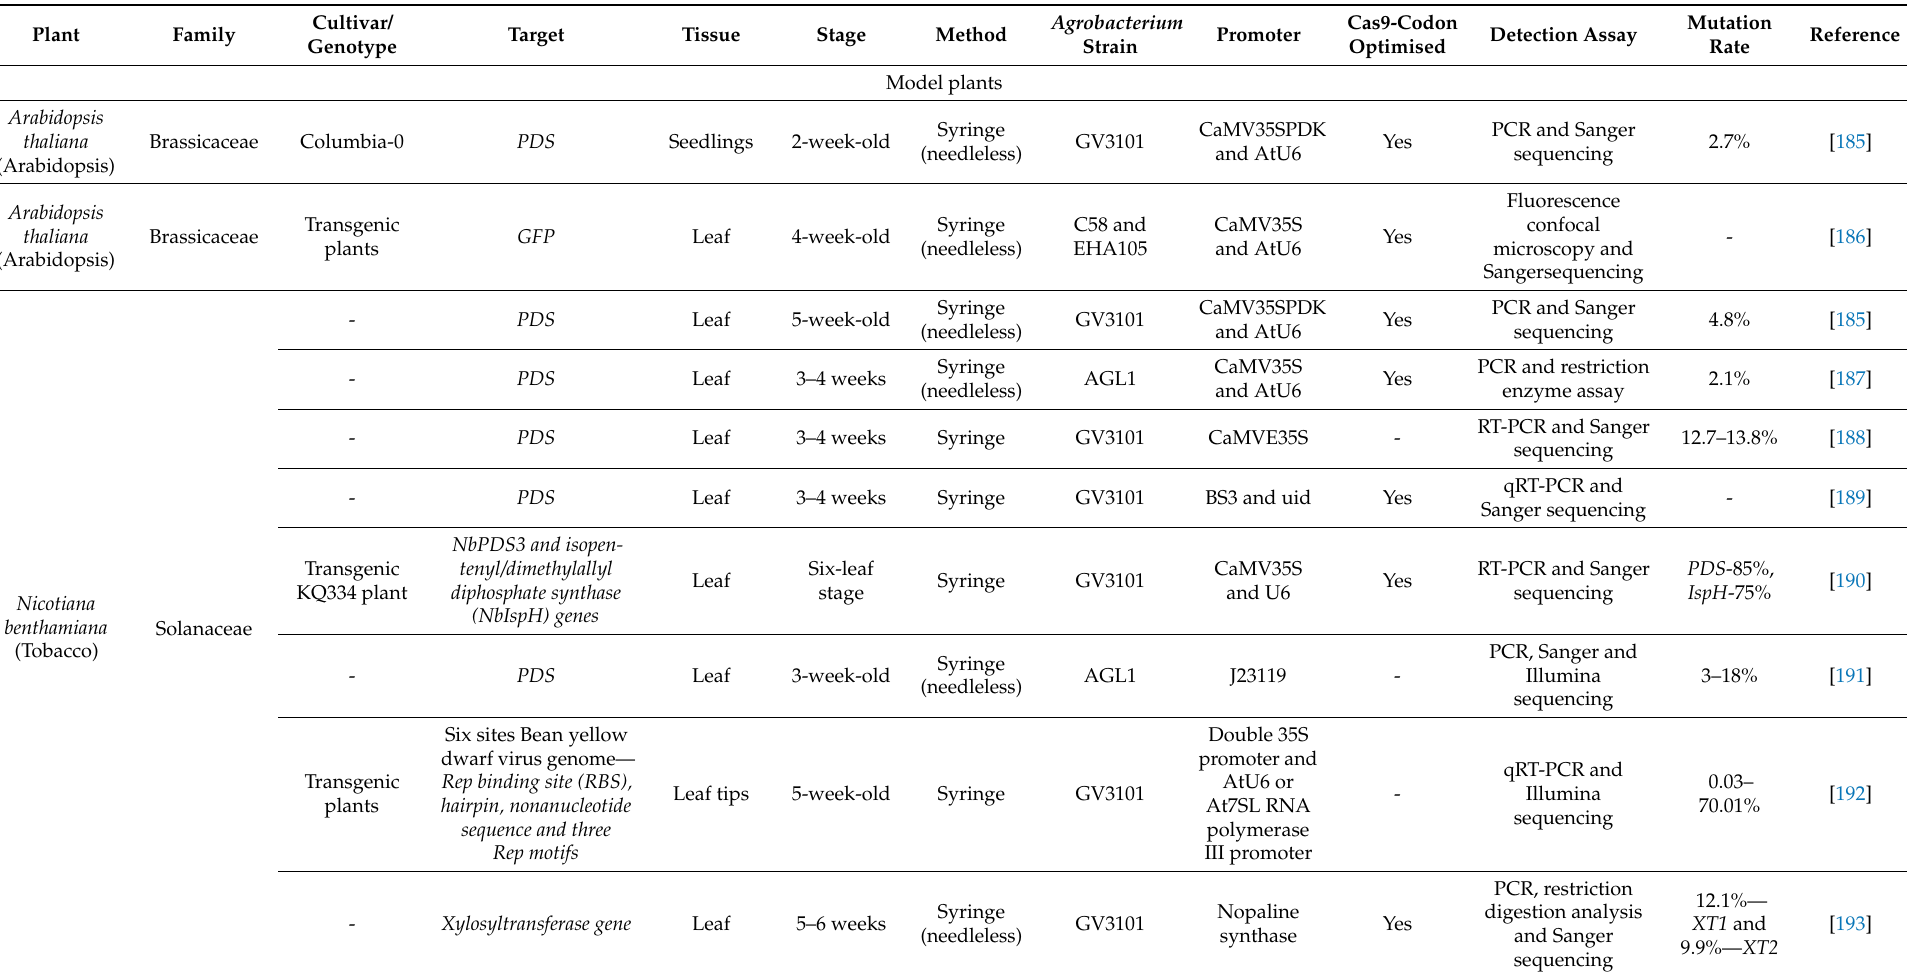
Table 2. Agroinfiltration based genome editing strategies for